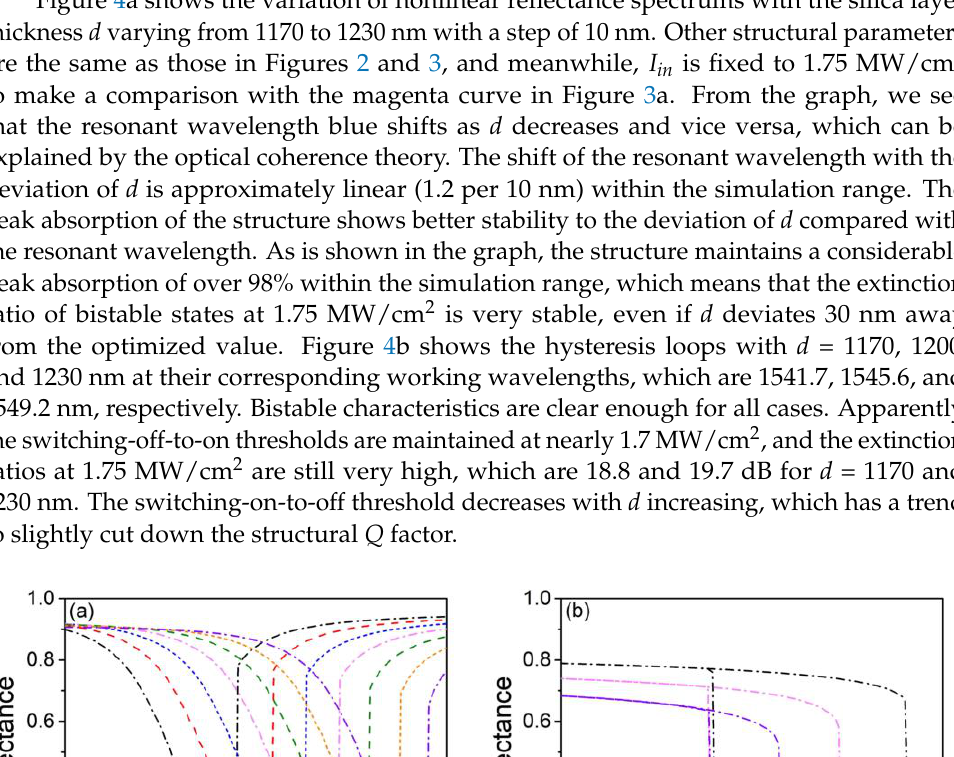
Figure 5. ( a ) Nonlinear reflectance spectrums with different grating thicknesses h . ( b ) Hysteresis loops with h = 52, 67, and 82 nm, respectively.